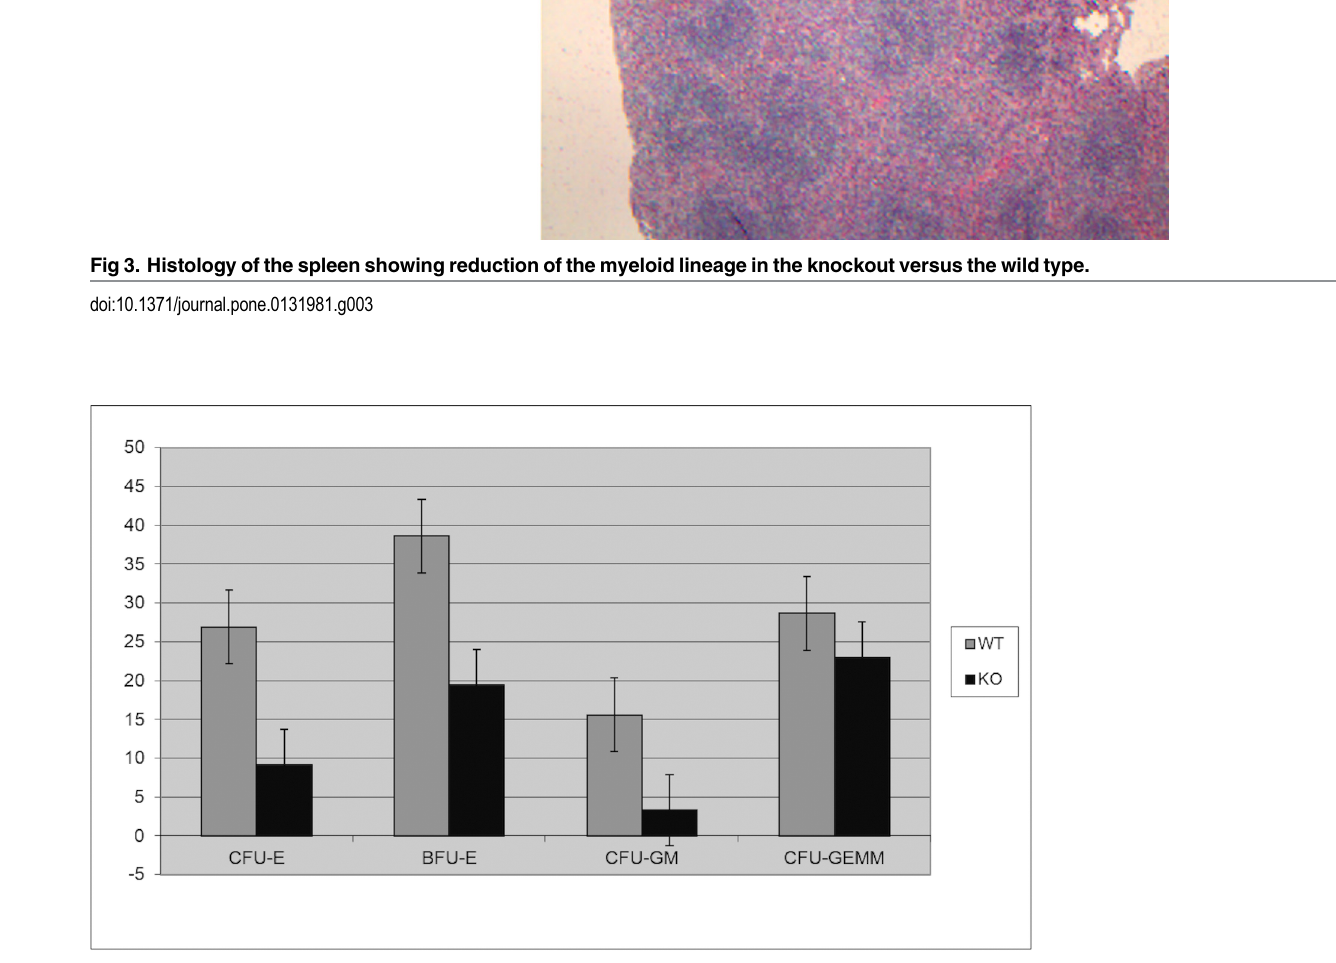
Fig 4. Colony forming assay on 2 months old miR29ab1 knockout bone marrows (n = 4; 2 WT and 2 KO; p = 0.04).